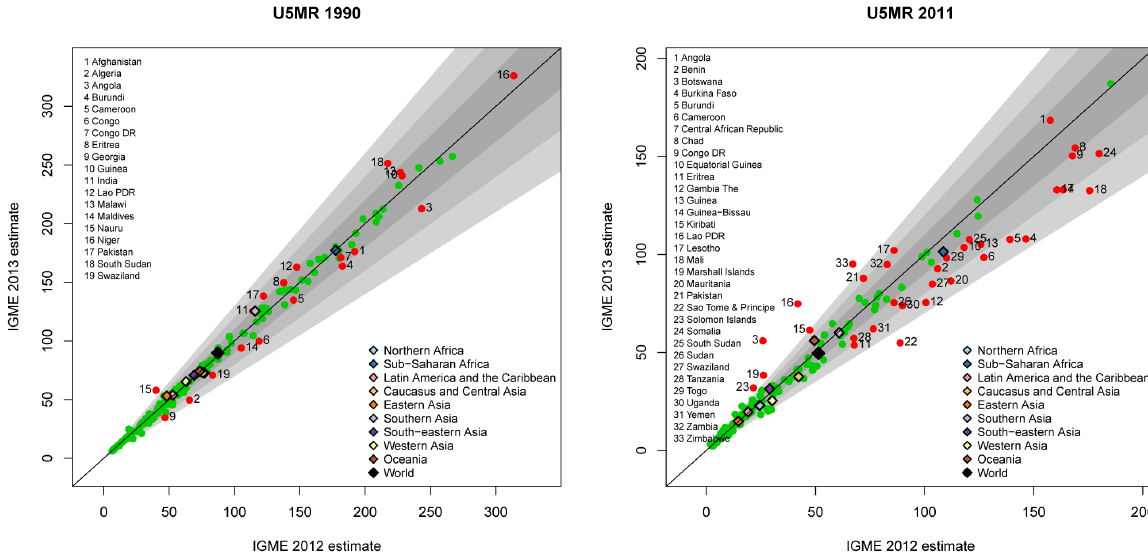
Figure 2. UN IGME 2013 and UN IGME 2012 estimates of the U5MR for the years 1990 (left) and 2011 (right). UN IGME 2013 estimates are plotted against UN IGME 2012 estimates. Gray areas represent relative differences of up to 10%, 20% and 30% respectively. Country-specific U5MR estimates are displayed as green points, or highlighted in red if the estimates differ by more than ten deaths per 1,000 live births. Regions are colored according to the given